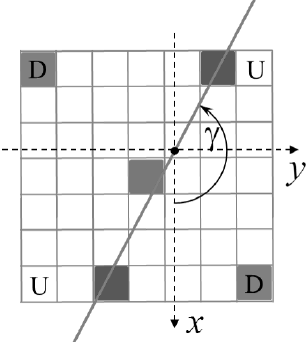
Figure 7. Mask for the box-based outlier identification technique (mask size: 7 × 7